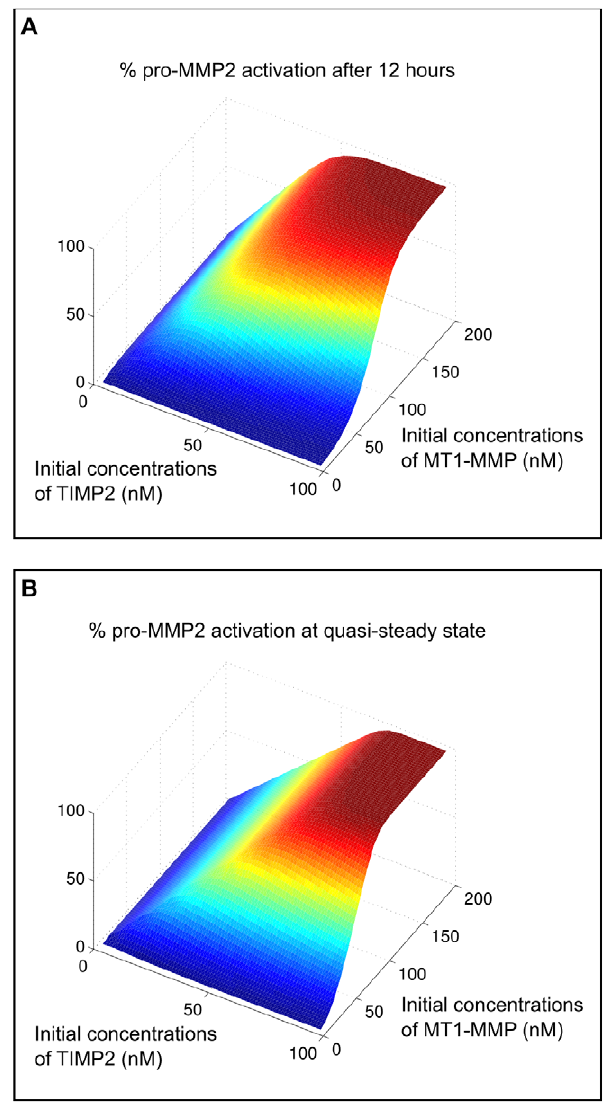
Figure 4. Activation/inhibition switch of MMP2 production. Here, we consider the full model of [23] including collagen degradation and ectodomain shedding of MMP-MT1. We computed the percentage of activated MMP2 depending on TIMP2 and MMP-MT1 after 12 hours A and after the system has reached a quasi-steady state B . doi:10.1371/journal.pone.0024246.g004 obtained when TIMP2 is absent for small amount of MT1-MMP of 41.7 nM processing 1.39 nM of pro-MMP2, these values corre- sponding to the 20 ng of MT1-MMP and 1 ng of pro-MMP2 used in